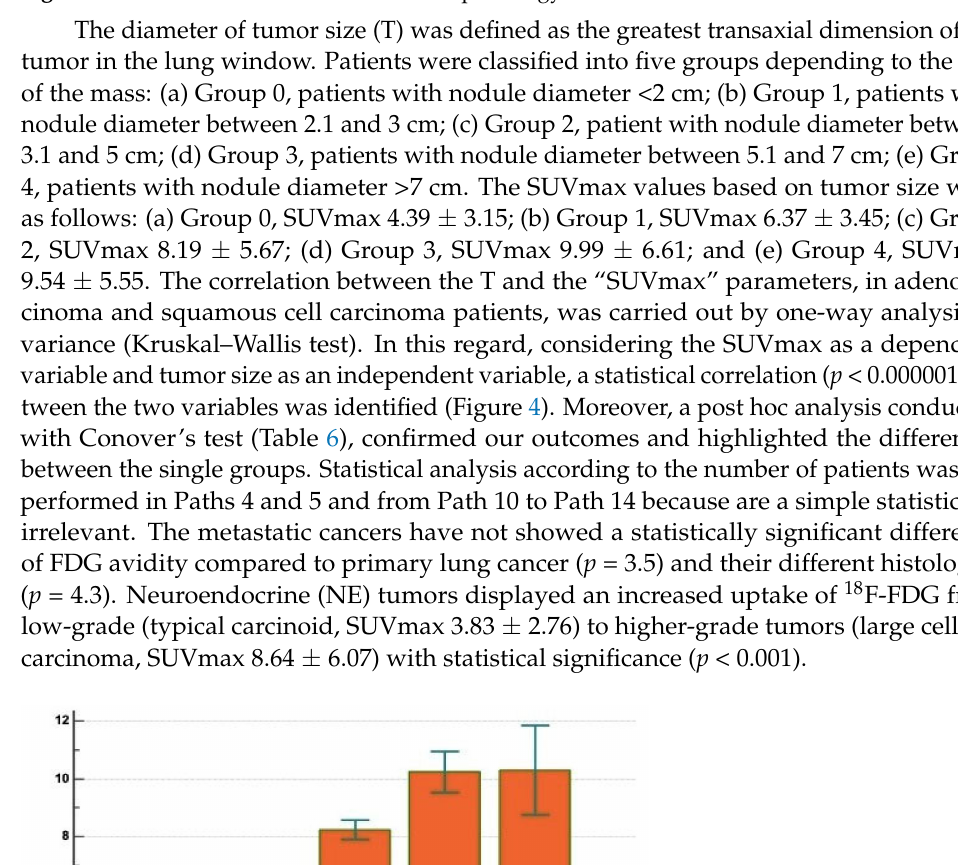
Figure 3. Correlation between SUVmax and pathology.